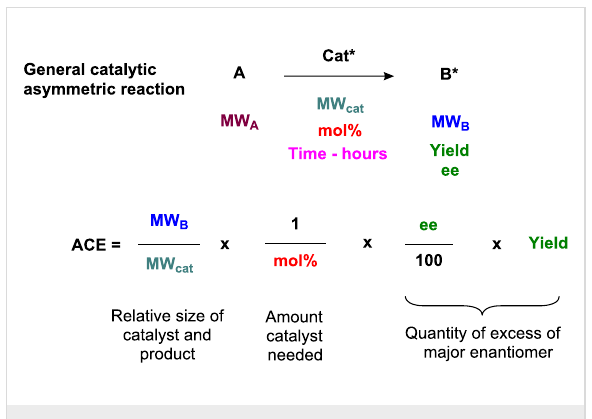
Figure 1: Definition of Asymmetric Catalyst Efficiency